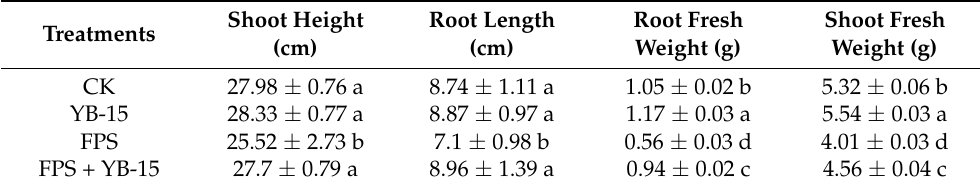
Table 2. Effects of B. subtilis YB-15 on the growth of wheat seedlings.